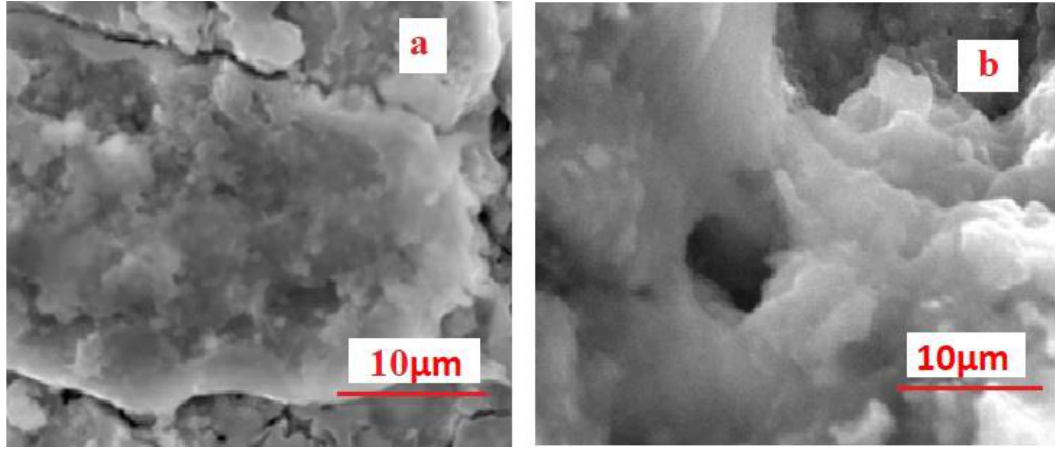
Figure 13. SEM images after potentiodynamic polarization of ( a ) DP rebar and ( b ) conventional rebar.